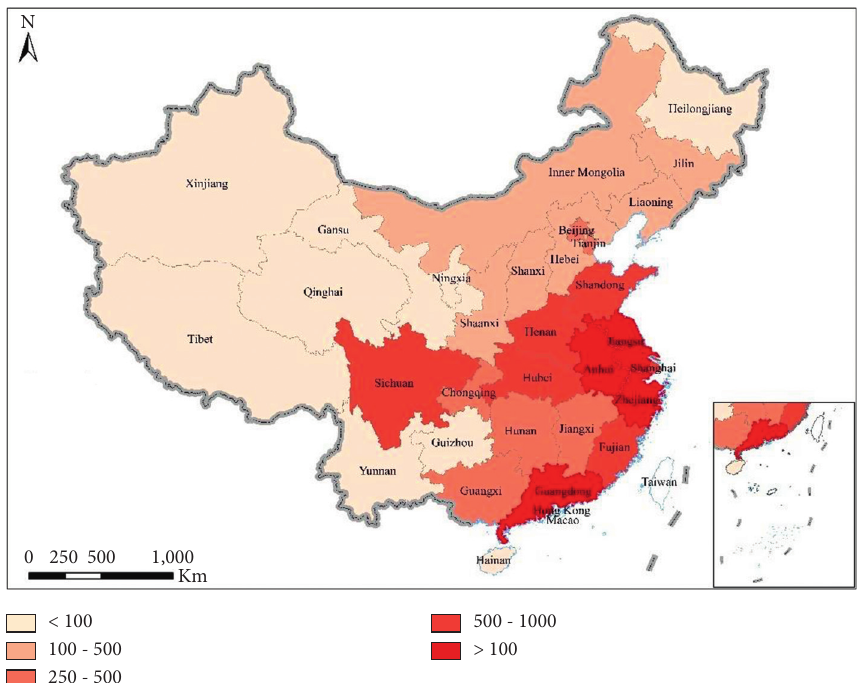
Figure 4: Distribution of new energy vehicle patents by provinces in